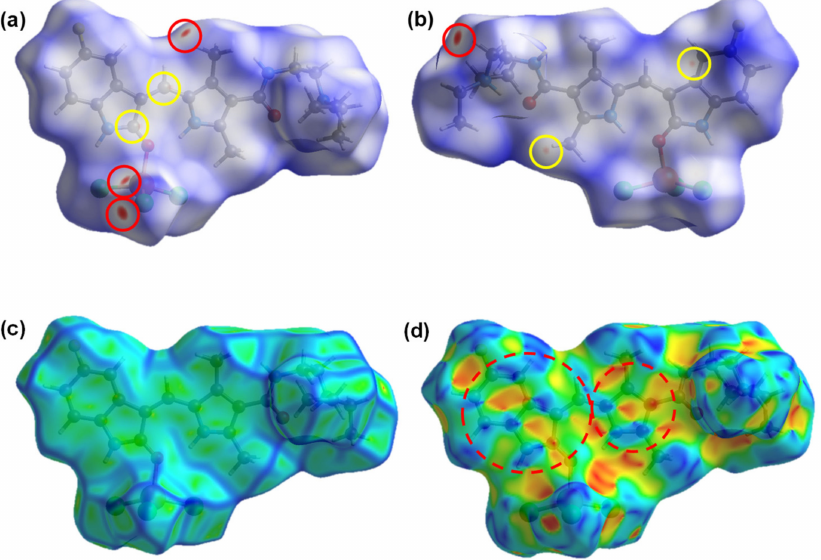
Figure 3. Front ( a ) and back ( b ) view of the Hirshfeld surface of the CuSun complex mapped with the d norm function, from − 0.10 to 1.68 (the red and yellow circles enclose regions with intermolecular contacts) and Hirshfeld surface of the CuSun complex mapped with ( c ) curvedness (values from − 4.0 to 0.4), and ( d ) shape index (values from − 1.0 to 1.0, the circles show regions indicative of π –stacking